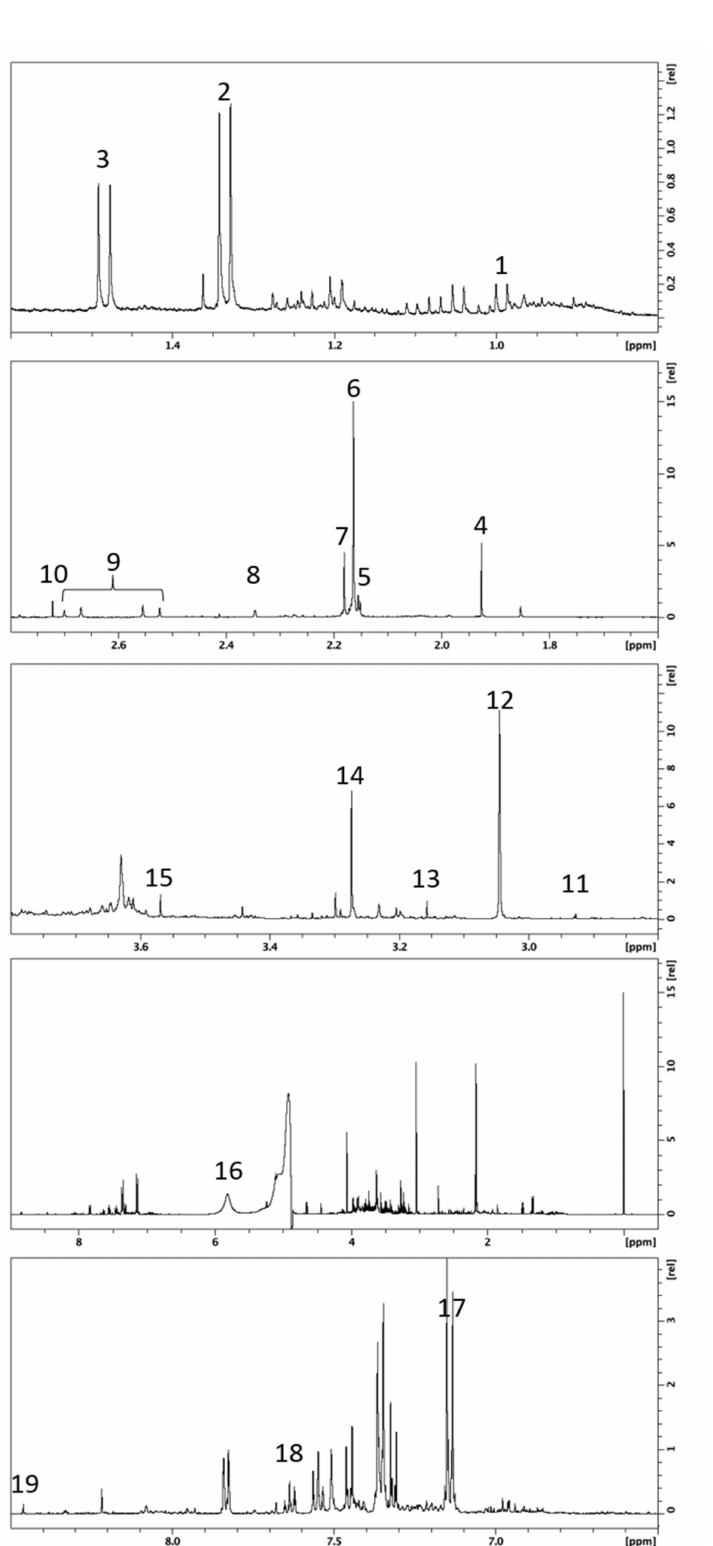
Figure 1. Typical 500 MHz 1 H NMR spectrum from one urine sample. Numbers refer to assigned metabolites presented in Table